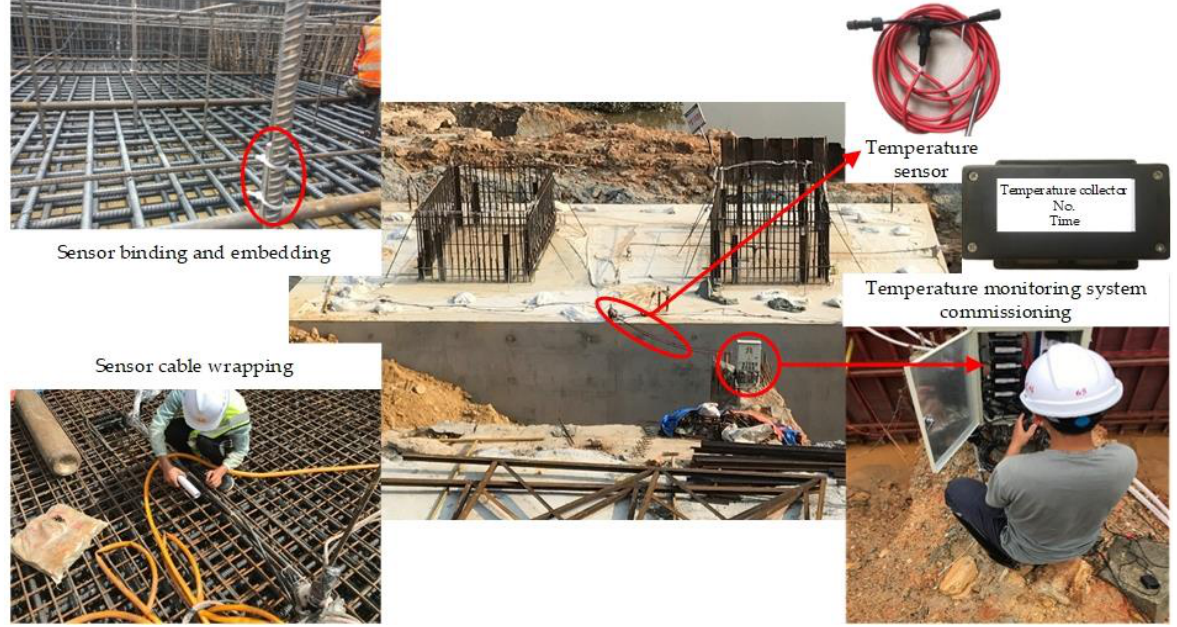
Figure 2. The temperature monitoring system of mass concrete in this